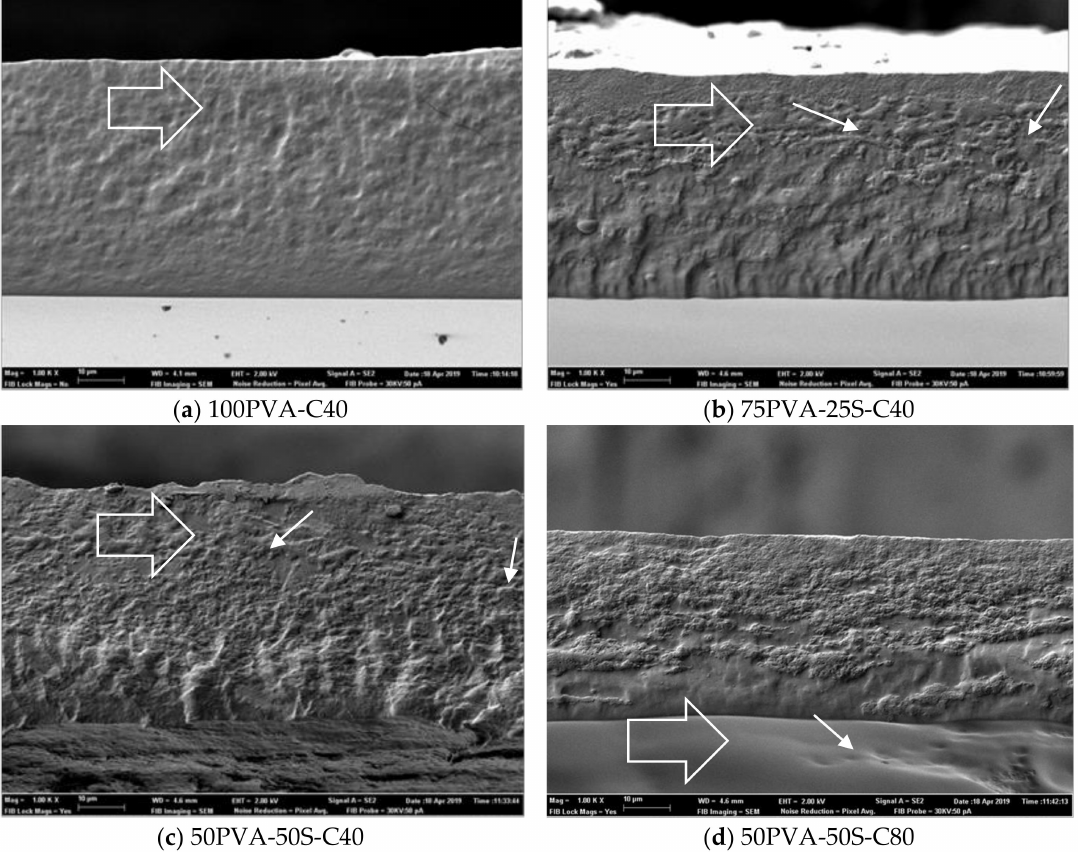
Figure 1. FESEM micrographs of the cross section of PVA composite films containing carvacrol. Big arrows indicate the upper part of the film in contact with the air during the drying process (top) and small arrows, the presence of carvacrol liquid clusters. ( a ) 100PVA-C40; ( b ) 75PVA-25S-C40; ( c ) 50PVA-50S-C40; ( d )